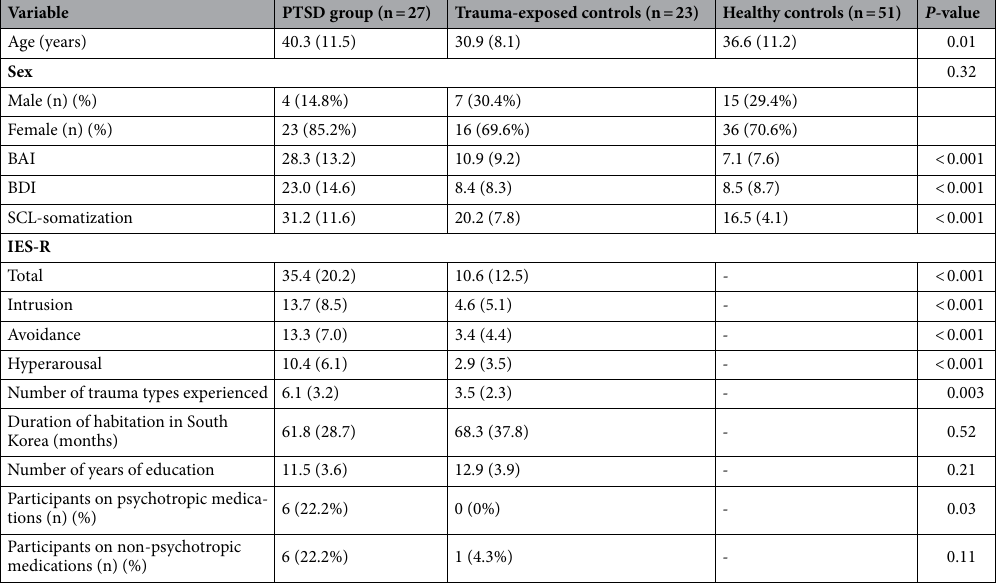
Table 1. Demographic and clinical characteristics of the participants. Continuous variables are presented as mean (standard deviation). PTSD post-traumatic stress disorder, BAI beck anxiety inventory, BDI beck depression inventory, SCL-somatization somatization subscale of Symptom Checklist-90-Revised, IES-R impact of event